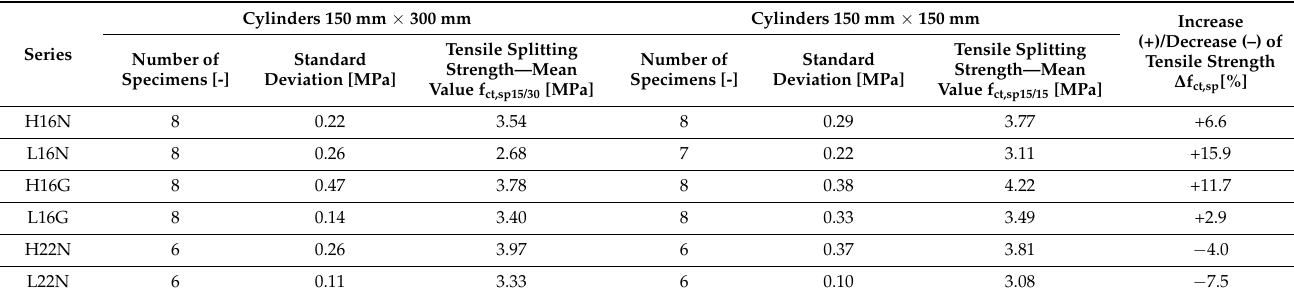
Table 4. Tensile splitting strength of concrete—test results.